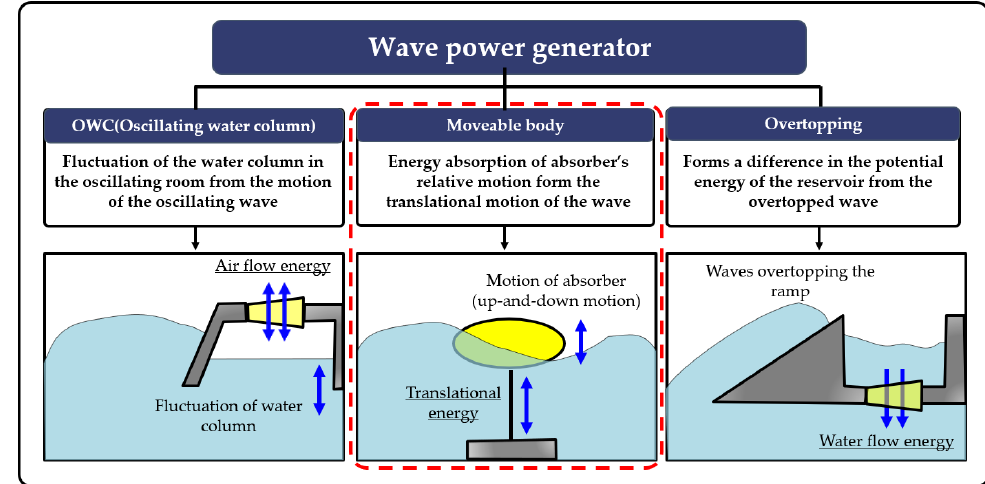
Figure 1. Classification of wave power generators.